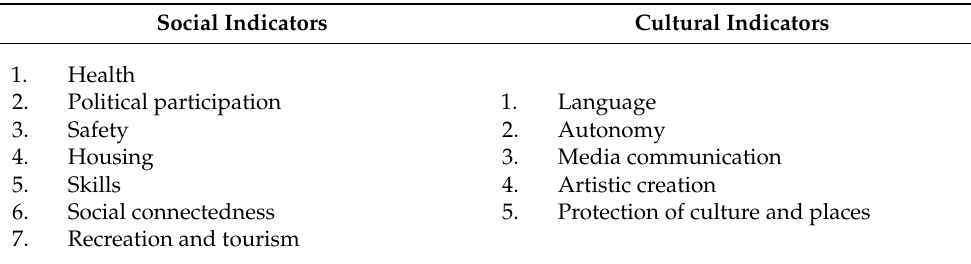
Table 3. Differentiation of social and cultural indicators